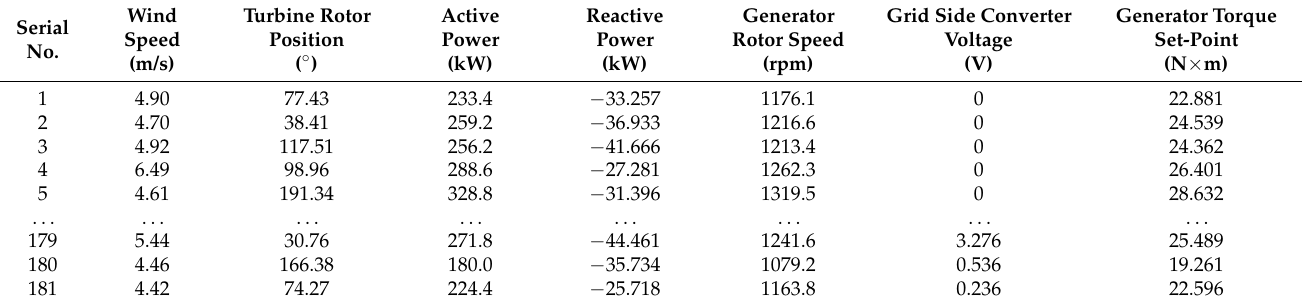
Table 1. Sample of fault indicator variable data of